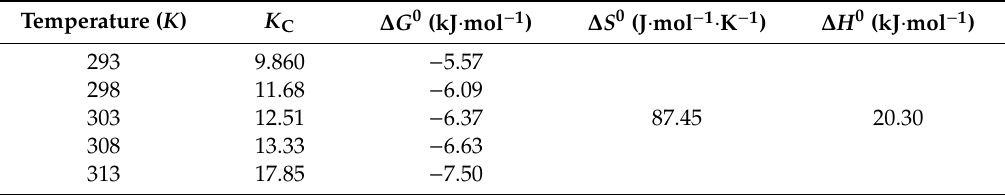
Figure 9. The thermodynamic and activation energy of adsorption. ( a ) Relationship between ln K C and 1/ T ; ( b ) the pseudo-second-order kinetics model; ( c ) Relationship between ln k and 1/ T . Table 4. Thermodynamic parameters at di ff erent